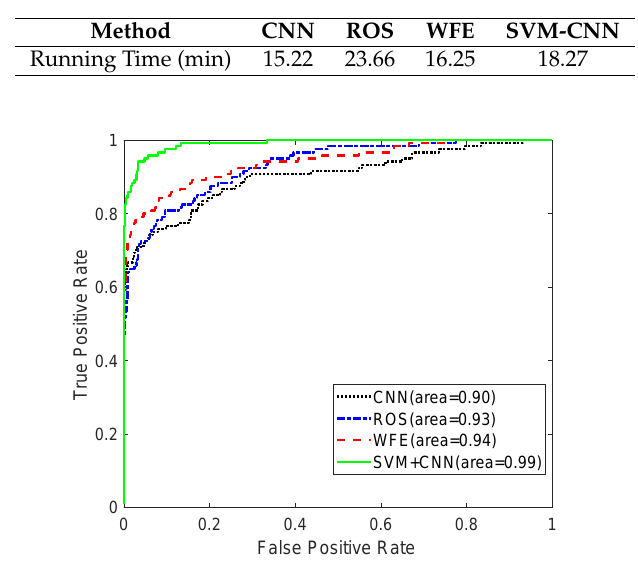
Table 5. Comparisons of execution time.